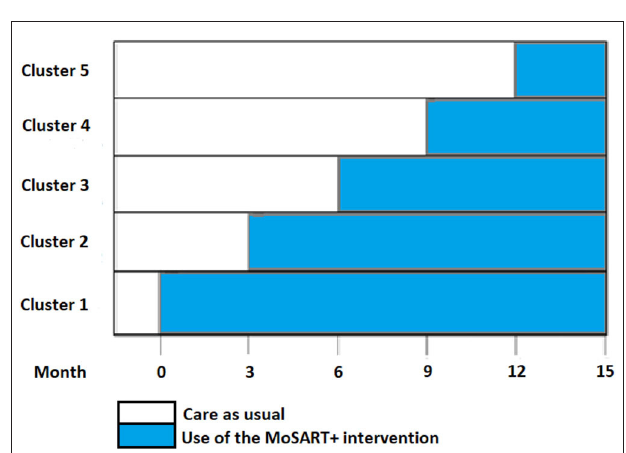
FIGURE 2 | Stepped-wedge cluster design over 15